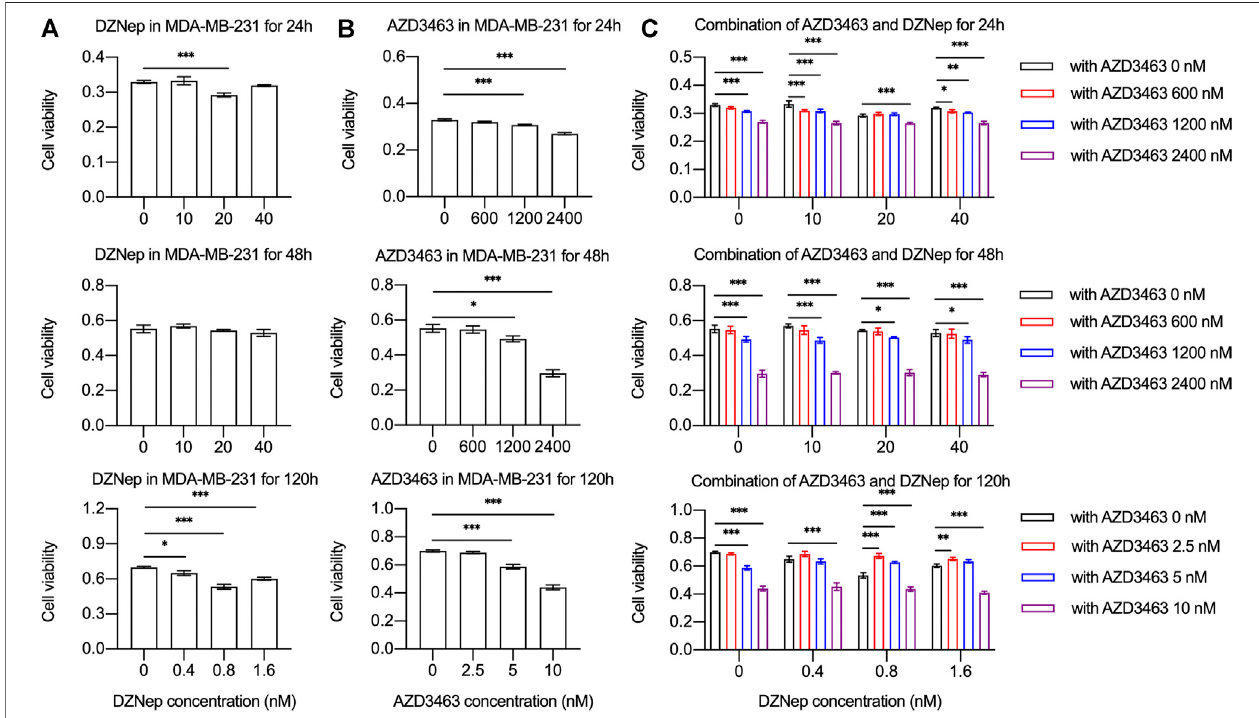
FIGURE 3 | DZNep and AZD3463 inhibited MDA-MB-231 breast cancer cell proliferation in vitro . MDA-MB-231 cell viability and proliferation (A) remained stable after treatment with DZNep (10, 20, and 40 nM) for 24 and 28 h, and with DZNep (0.4, 0.8, and 1.6 nM) for 120 h, (B) signi fi cantly decreased after treatment with AZD3463(1,200,and2,400 nM)for24and48 h,andwithAZD3463(5,and10 nM)for120 h,and (C) signi fi cantlydecreasedaftertreatmentwithAZD3463(1,200,and 2,400 nM) and combination treatment (DZNep: 10, 20, and 40 nM; and AZD3463: 600, 1,200, and 2,400 nM) for 24 and 48 h, and after treatment with AZD3463 (5, and 10 nM) and combination treatment (DZNep: 0.4, 0.8, and 1.6 nM; and AZD3463: 2.5, 5, and 10 nM) for 120